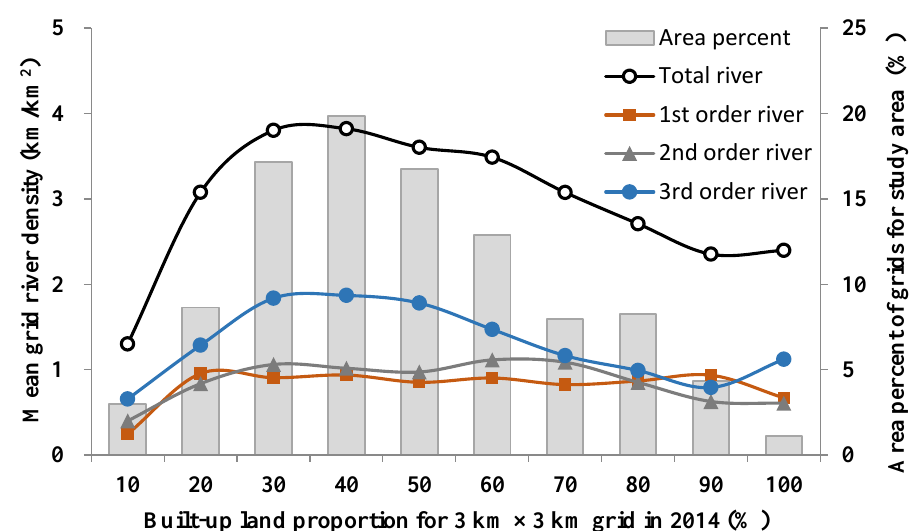
Figure 9. Relationship between the proportion of built-up land and the evolution of river systems. Note that the label “10” in the horizontal axis shows that the built-up land proportion for a 3 km × 3 km grid is greater than or equal to 0 and less than 10, and so on.